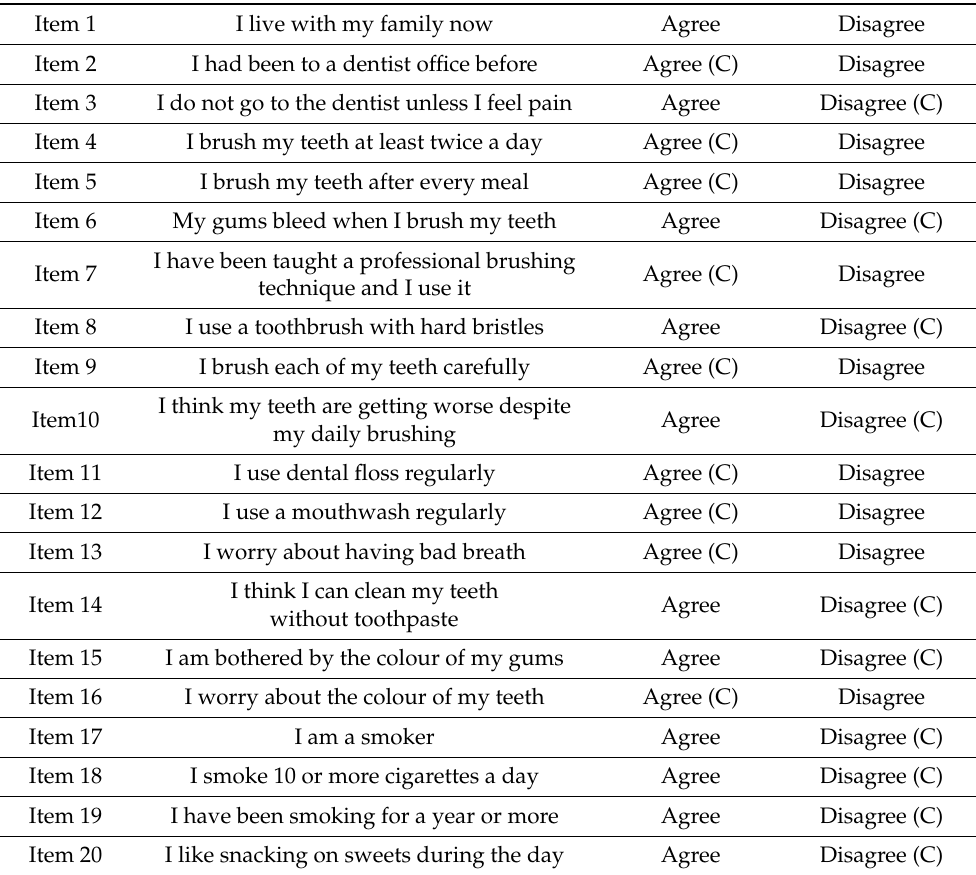
Table 1. The modified English version of the Hiroshima University-Dental Behaviour Inventory (HU-DBI) survey in this study. Answers favouring correct oral health attitudes and behaviour are marked with